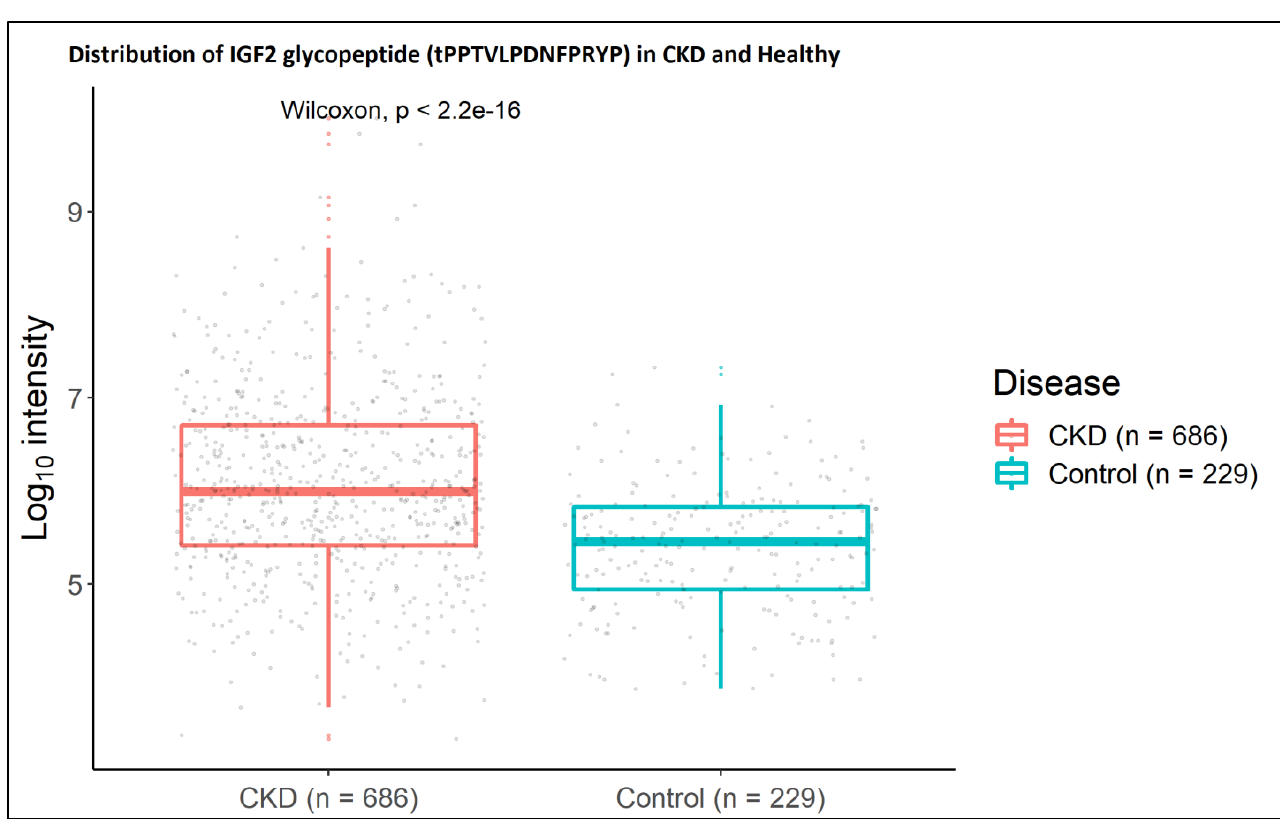
Figure 6. Box-Whisker plot depicting the increased urinary levels of IGF2 glycopeptide – tPPTVLPDNFPRYP in CKD subjects in comparison to healthy control subjects from the Human urinary proteome database.